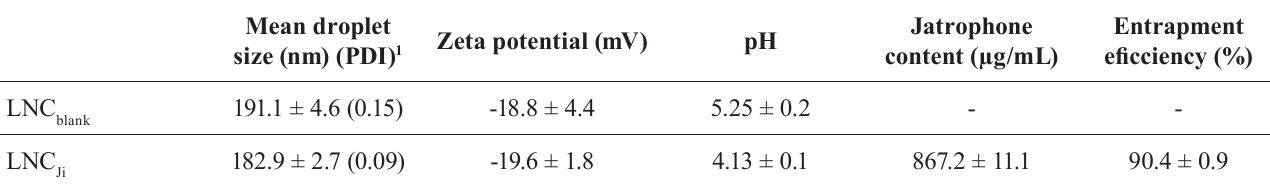
Table II - Physicochemical and loading properties of the lipid